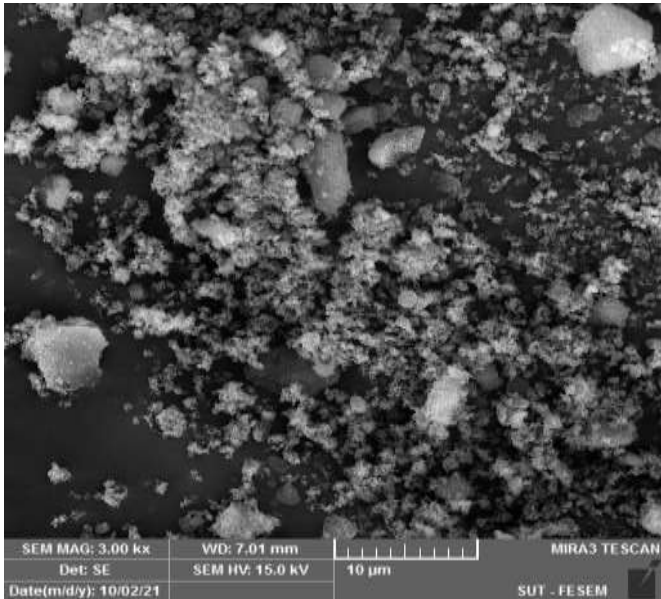
Figure 5: The morphological surface topography of Al 2 O 3 NPs by